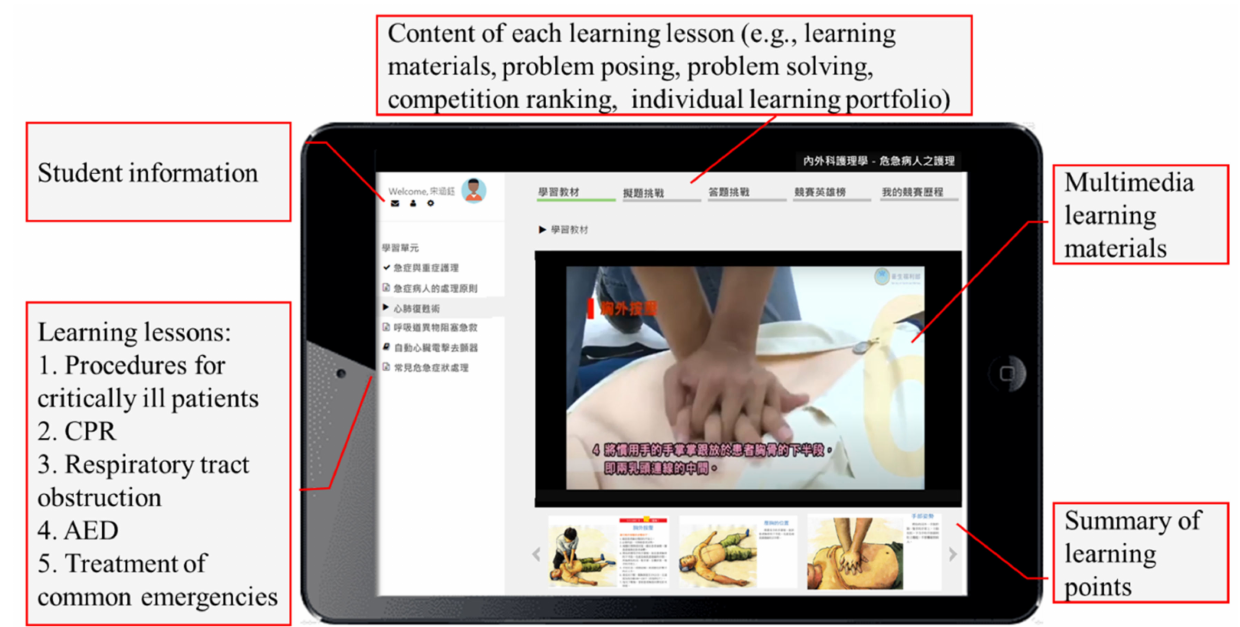
Figure 2. The competition-based problem-posing mobile learning